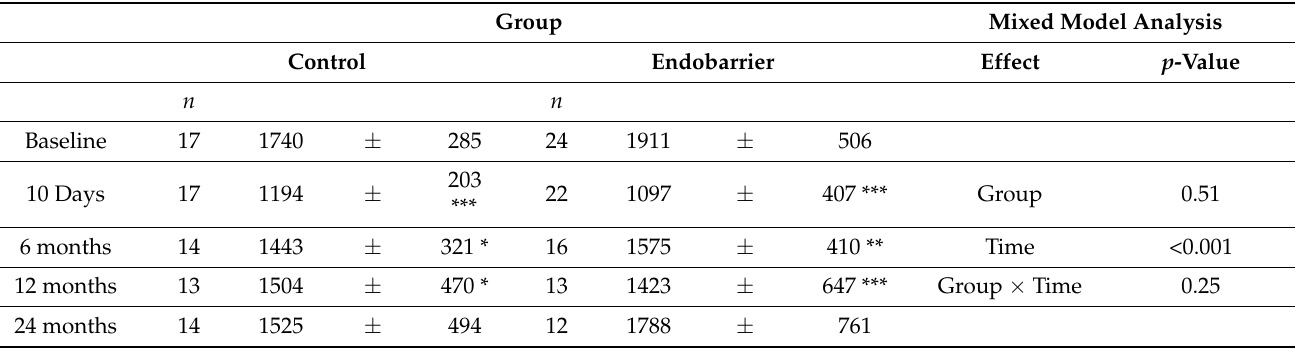
Table 2. Total daily caloric intake (kcal).